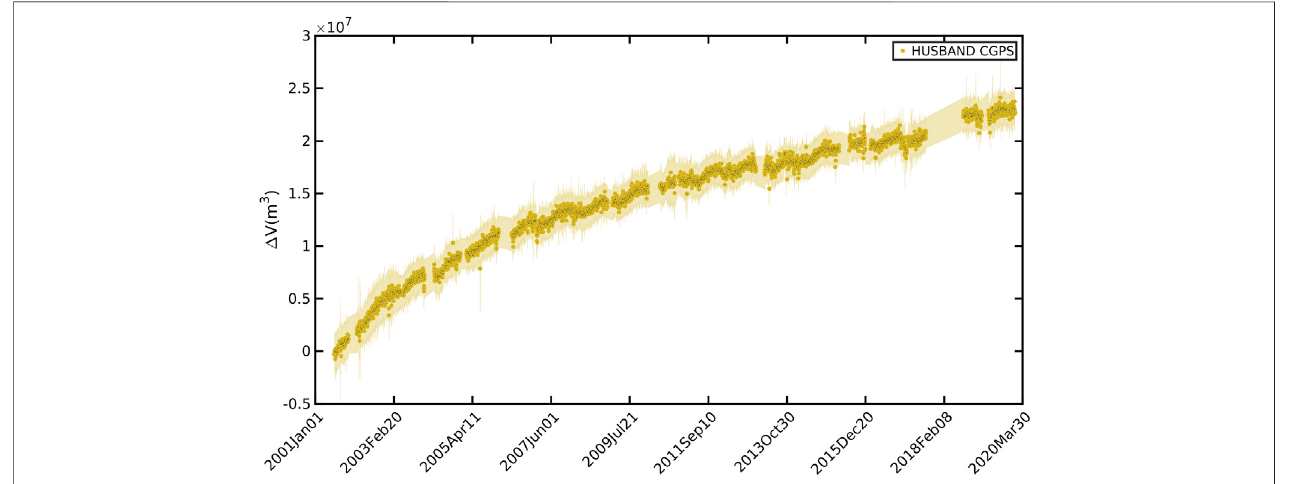
FIGURE 7 | Cumulative increments of volume changes for the CGPS station, Husband. The fi gure shows the results according with the median value for the source depth.